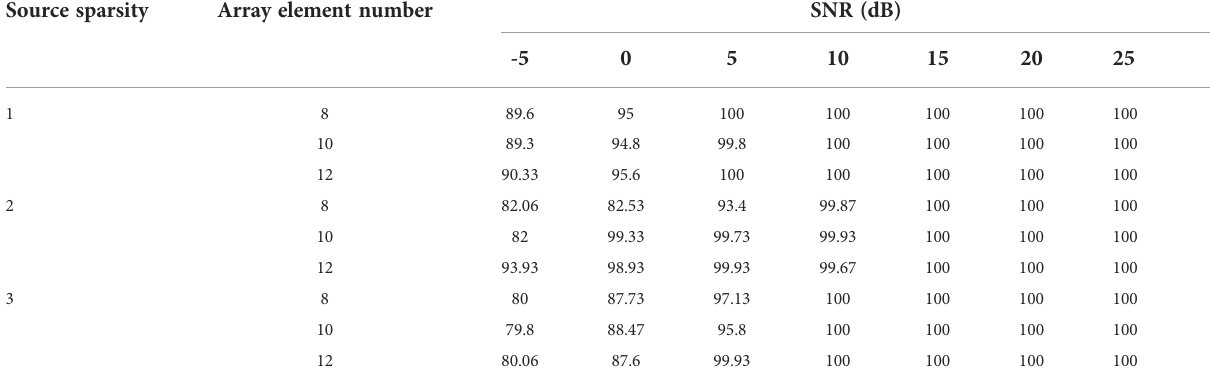
TABLE 3 The accuracy of the source sparsity prediction model for different SNR values, array types, and source sparsity. Source sparsity